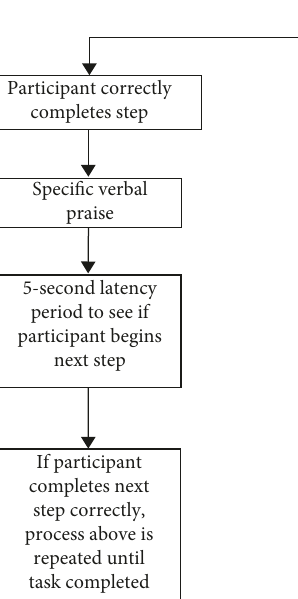
Figure 2: Video modeling intervention